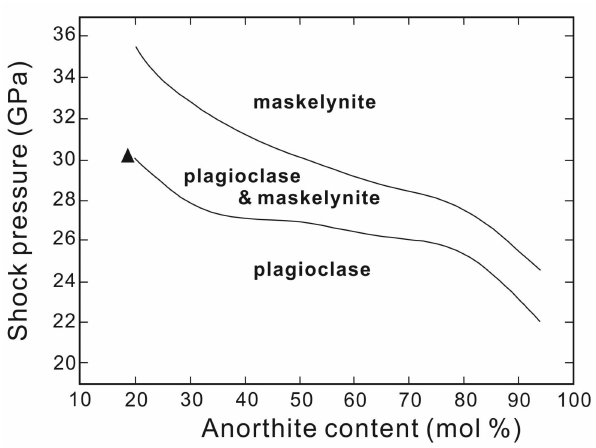
Figure 6. Pressure-composition phase diagram for shocked plagioclase (Filled triangle represents this study). Modified after Fritz et al.